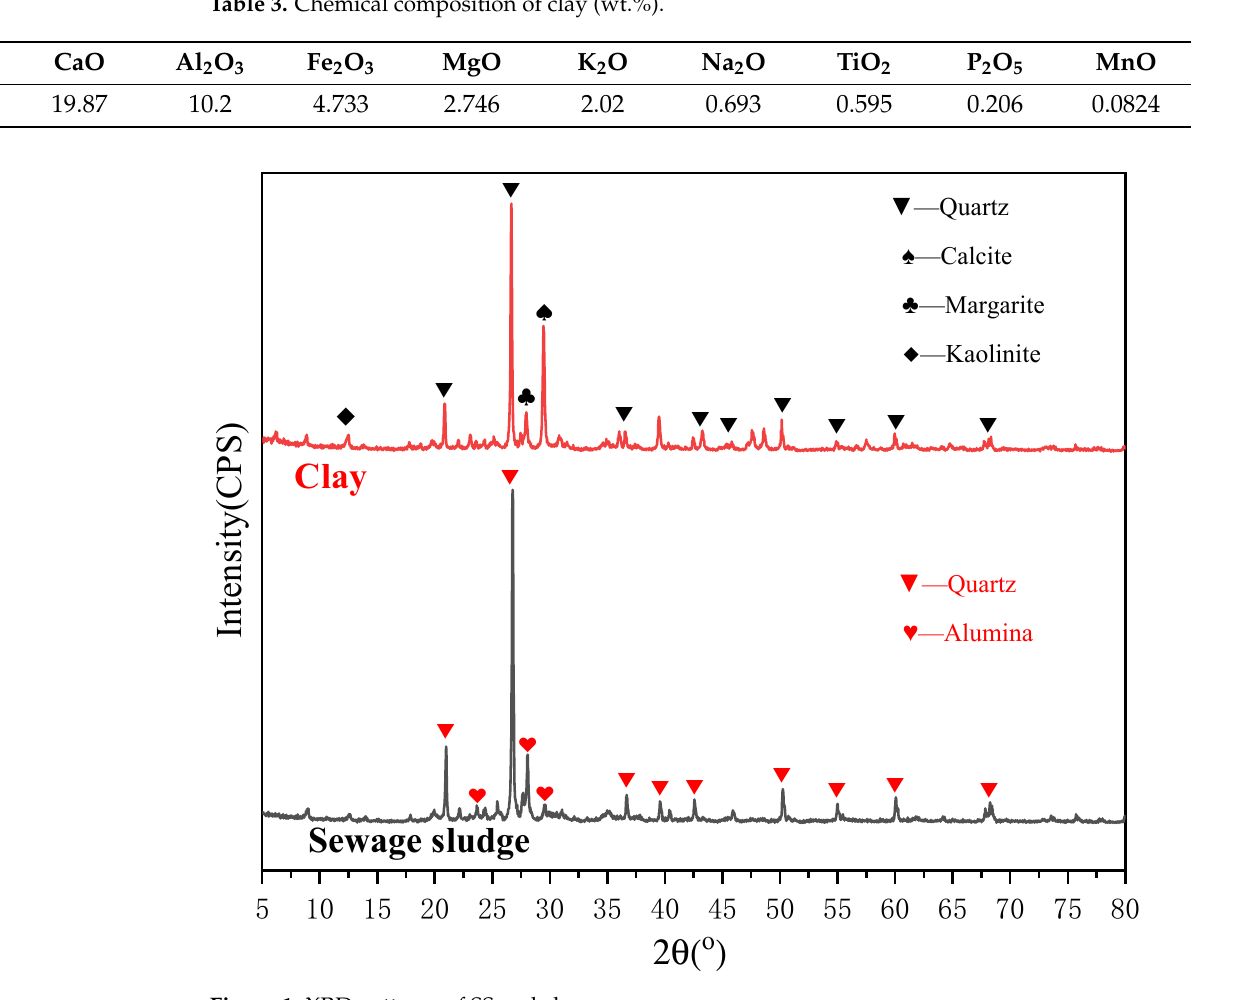
Figure 1. XRD patterns of SS and clay.